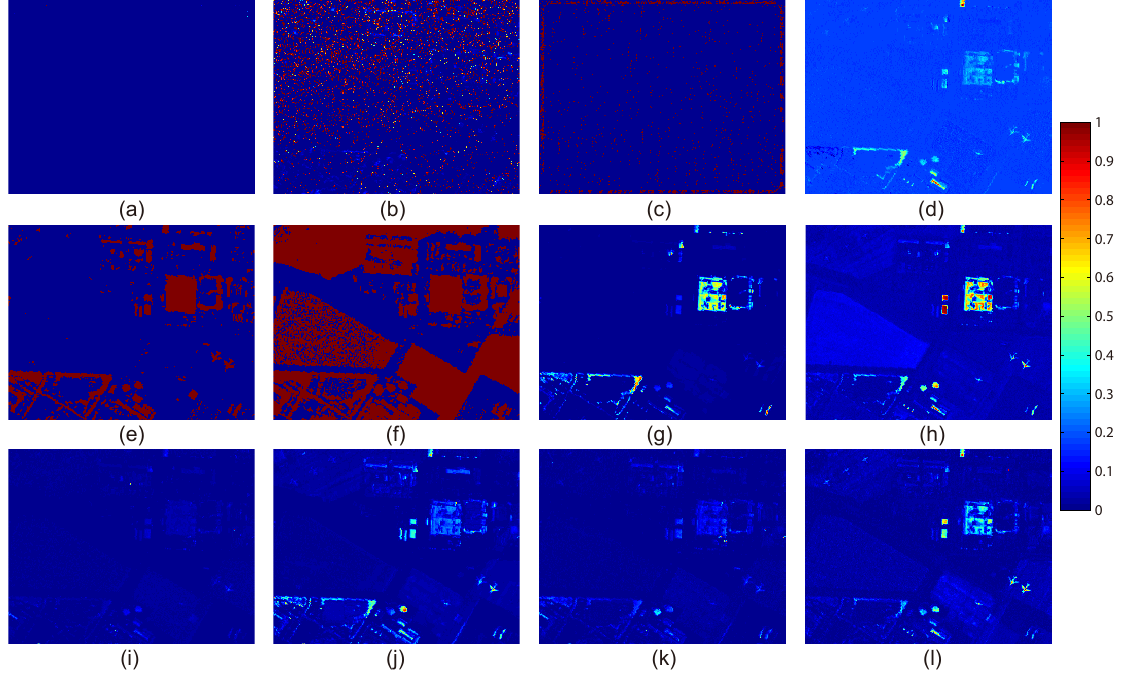
Figure 5. The visualization results of different detectors on AVIRIS2 data set. ( a ) LRX: window size (19,9); ( b ) SRD: window size (19,9); ( c ) CRD: window size (19,9); ( d ) LSMAD; ( e ) RSAD; ( f ) BACON; ( g ) BACON-target; ( h ) GKRX; ( i ) GRX; ( j ) PCA-GRX; ( k ) Ours-withoutMV; ( l ) Ours. Values in the color bar represent the anomaly